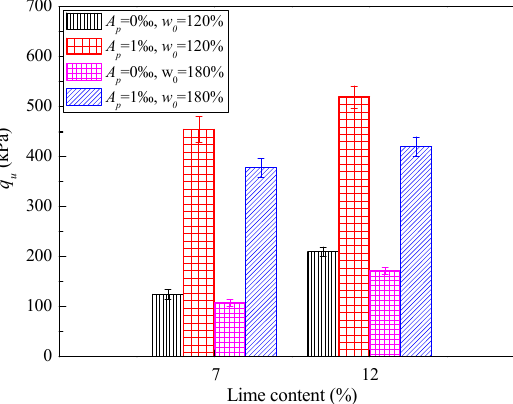
Figure 2. Effect of SAP content on q u (w 0 = 120%).